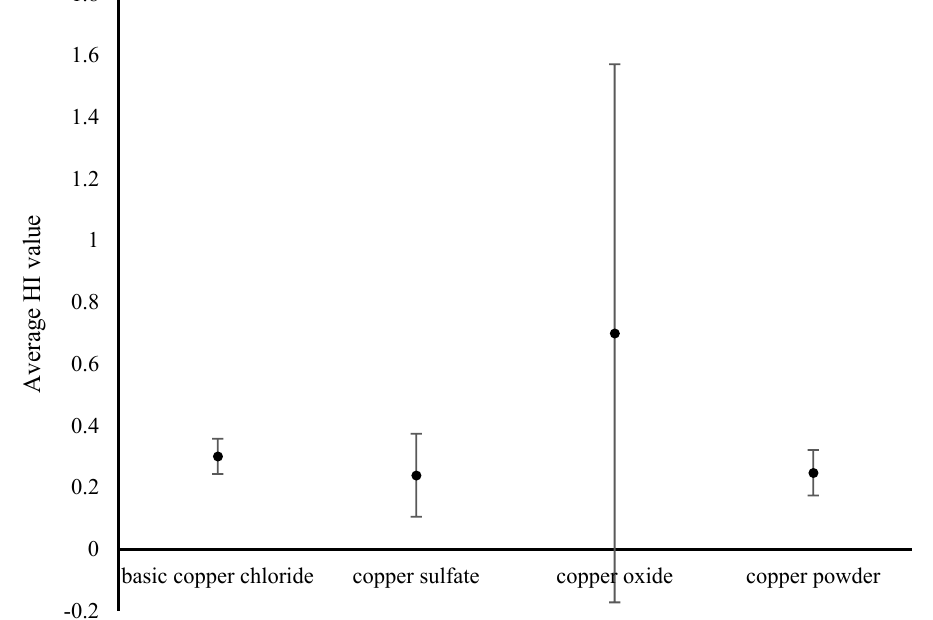
Figure 4. Average HI values (± standard deviation) for different types of the recycled products.